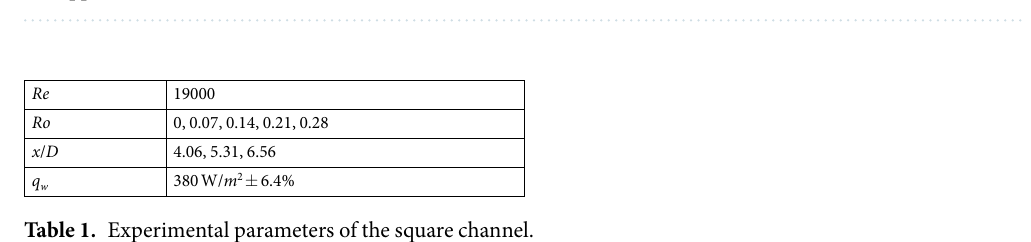
Figure 4. The parallel-array probe. ( a ) The main parameters of the probe; ( b ) The arrangement of the probe and its